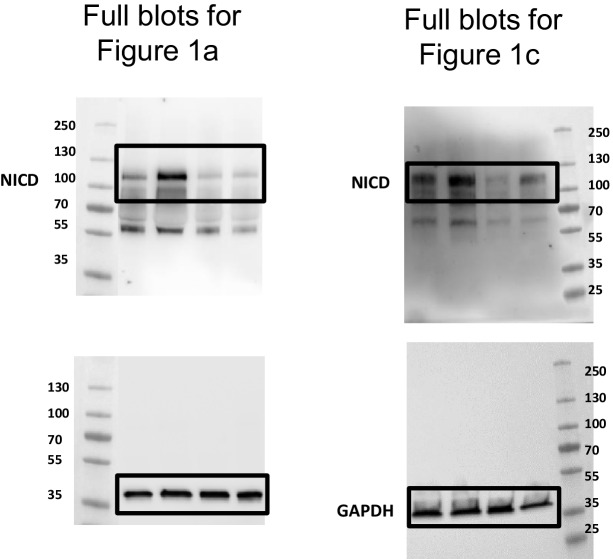
Uncropped western blots for Figure 1a and Figure 1c.